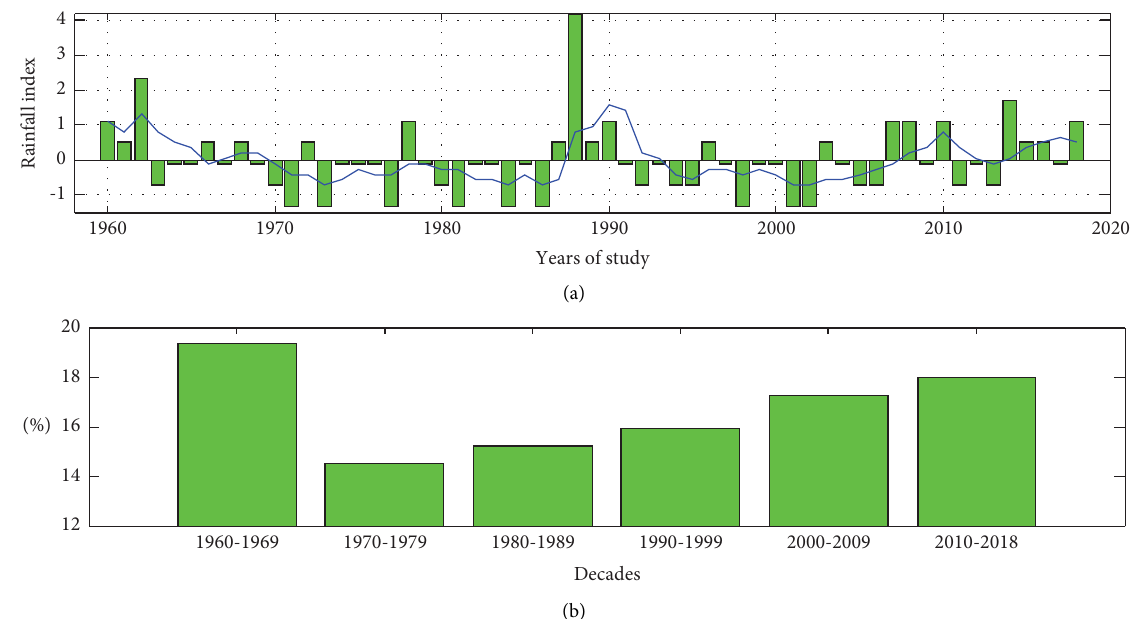
Figure 4: Interannual variation with moving average over three years (a) and decade proportions (b). Table 3: Tau ( r ) and p value ( p ) of Kendall’s test. Over the entire study period